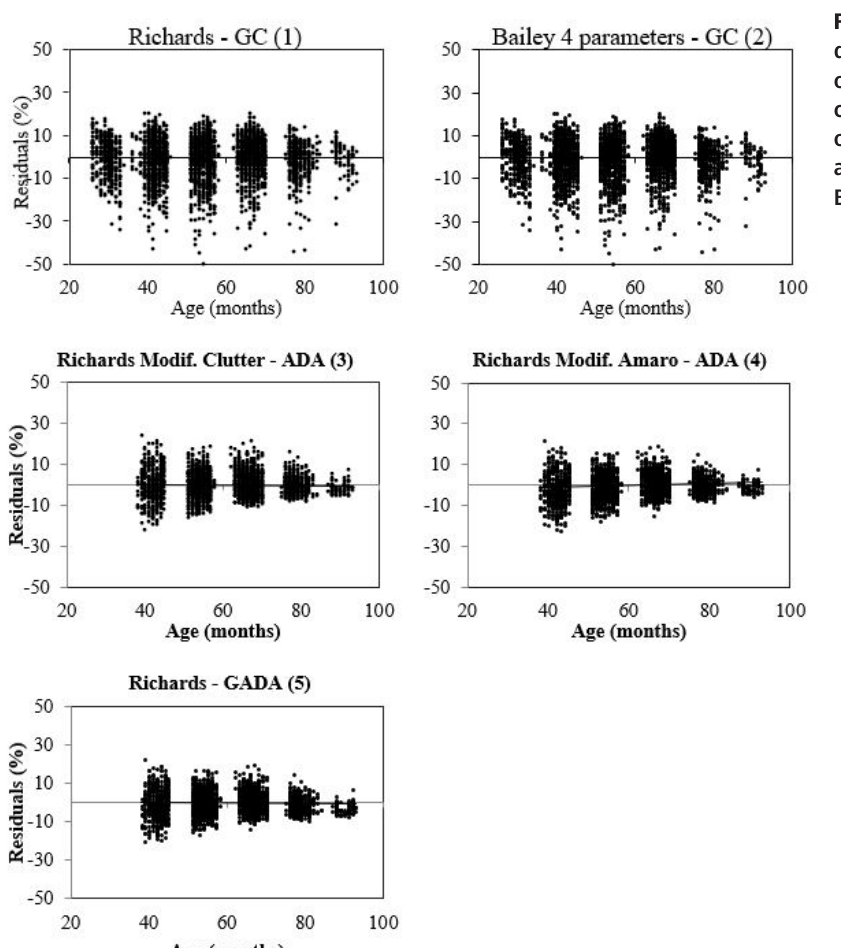
Figure 2. Residual